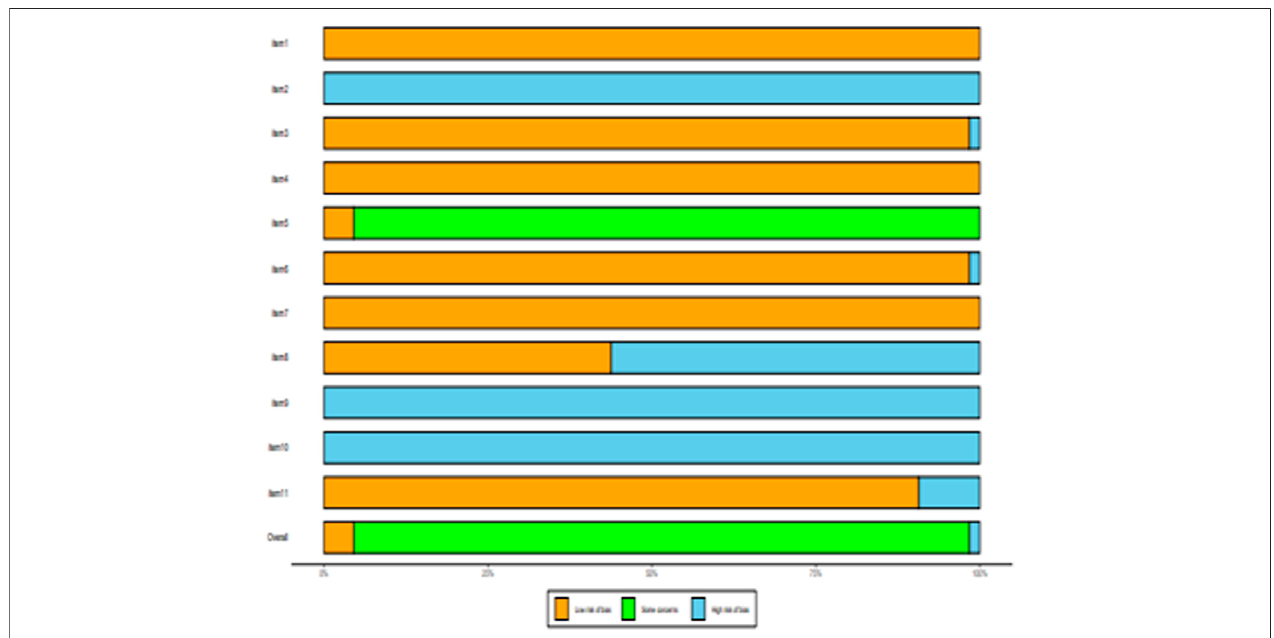
FIGURE 2 | Risk-of-bias summary of included studies using the AHRQ risk-of-bias tool.